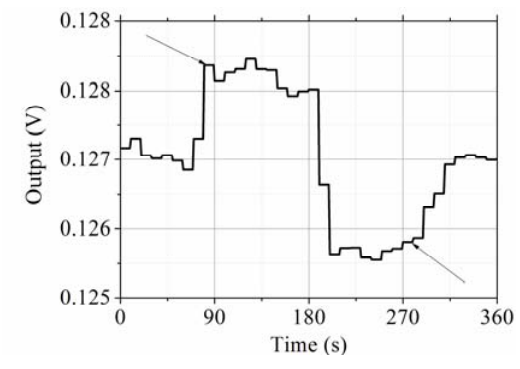
Figure 16. Sensitivity